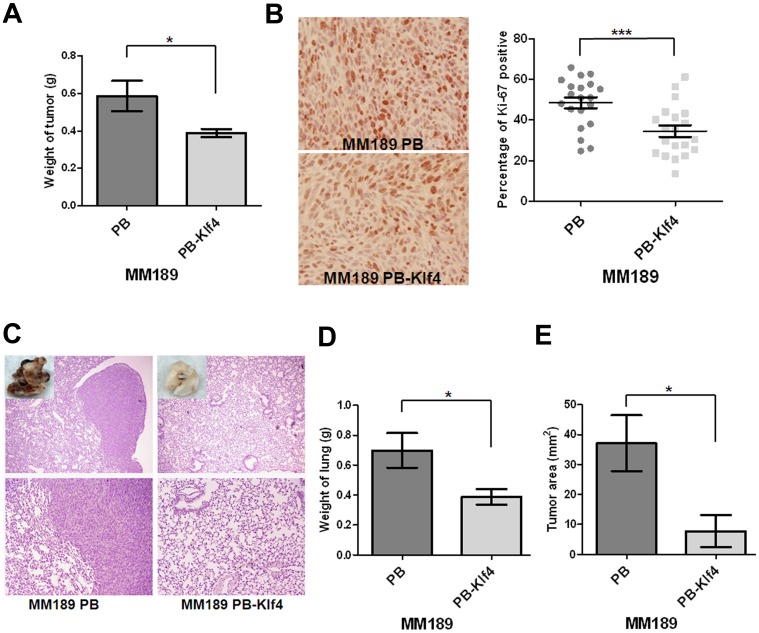
Klf4 suppressed tumor growth and lung colonization.(A) Quantification of the weight of the tumor lesions in mice (n = 7) subcutaneously injected with MM189 PB-Klf4 or MM189 PB cells. Bar, SE. *, p<0.05. (B) The representative field for detection of Ki-67 expression by immunohistochemistry under the light microscope with 200× magnification in the left panel. The percentage of positive Ki-67 stain was defined as the intensity of positive nuclei divided by that of the total nuclei in the field. Bar, SE. ***, p<0.001. (C) Representative lung fields of nude mice after the delivery, via tail vein injection, of MM189 cells with ectopic Klf4 expression (MM189 PB-Klf4) or vector controls (MM189 PB). The boxed area in the upper panel was shown with macroscopic view. The upper panel was observed at lower magnification (40×) and the lower was for higher magnification (100×). (D) Quantification of weight of the lung lesions in mice (n = 6) injected with MM189 PB-Klf4 or MM189 PB cells. Bar, SE. *, p<0.05. (E) Quantification of total areas of the tumor lesions in lungs of mice (n = 6) injected with MM189 PB-Klf4 or MM189 PB cells. Bar, SE. *, p<0.05.